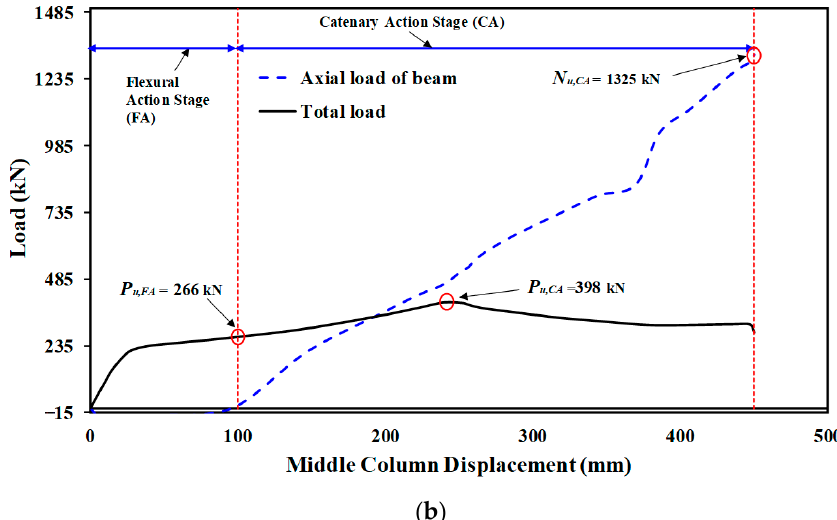
Figure 7. Characteristics of force and center steel-column displacement for J-S-S-EX ( a ) Curves of force and center column displacement, and ( b ) Curves of CA & flexural phases [29].